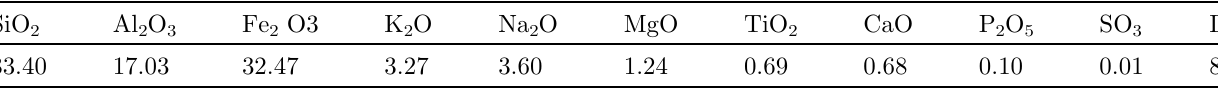
Table 1. Chemical composition (mass %) of the clay.